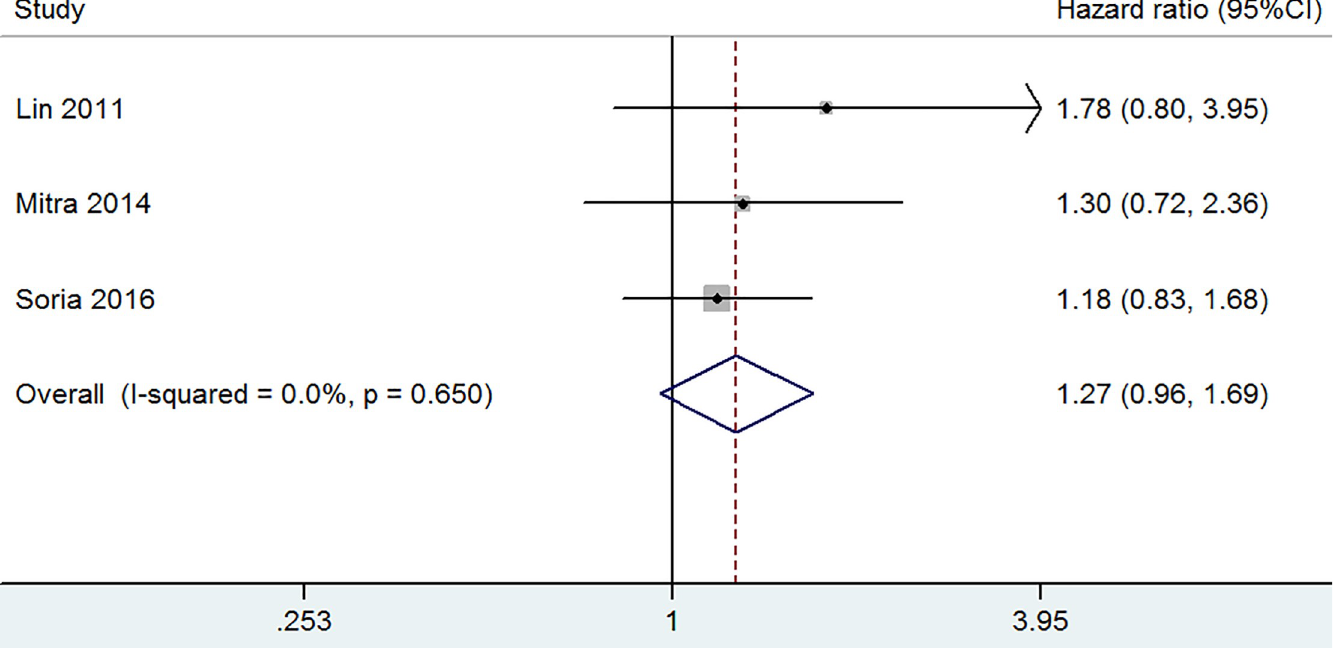
Fig 5. The hazard ratio (HR) of preoperative hydronephrosis associated with RFS in bladder cancer patients.